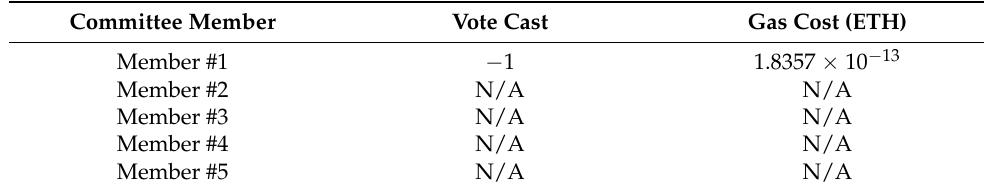
Table 6. Veto mode votes and gas costs.